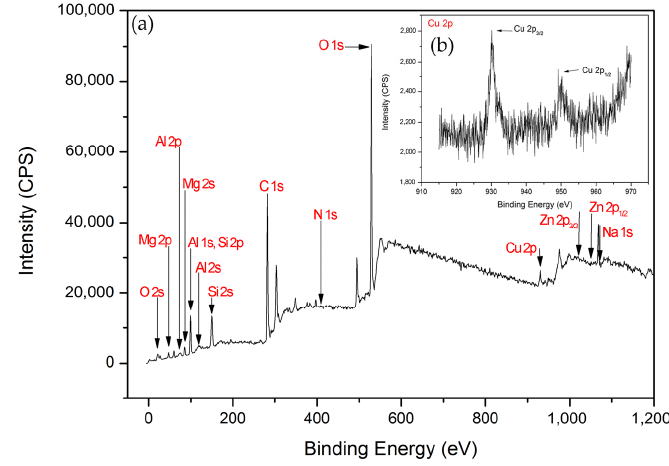
Figure 5. ( a ) XPS survey scans of Cu/MAO/AZ31 coating, ( b ) XPS spectra of Cu